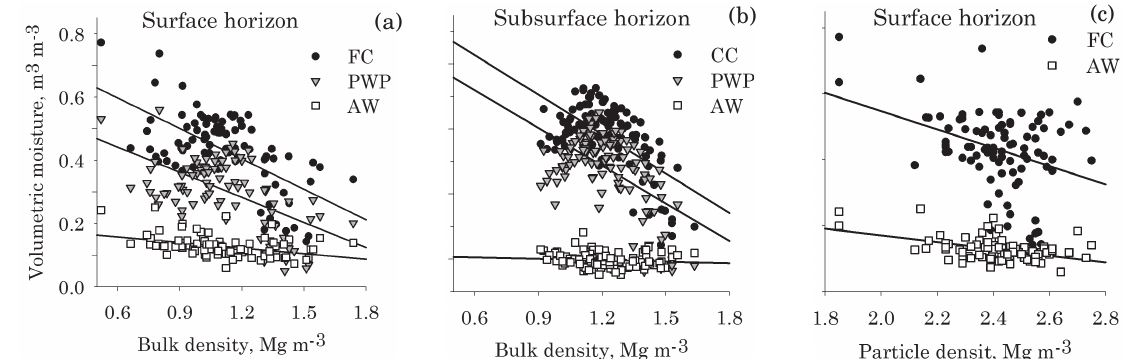
Figure 3. Scatter plots between field capacity (FC) and permanent wilting point (PWP) versus bulk density in the surface (a) and subsurface (b) horizons, and between field capacity (FC) and available water content (AW) versus particle density in the surface (c) horizons in soils of the State of Santa Catarina.